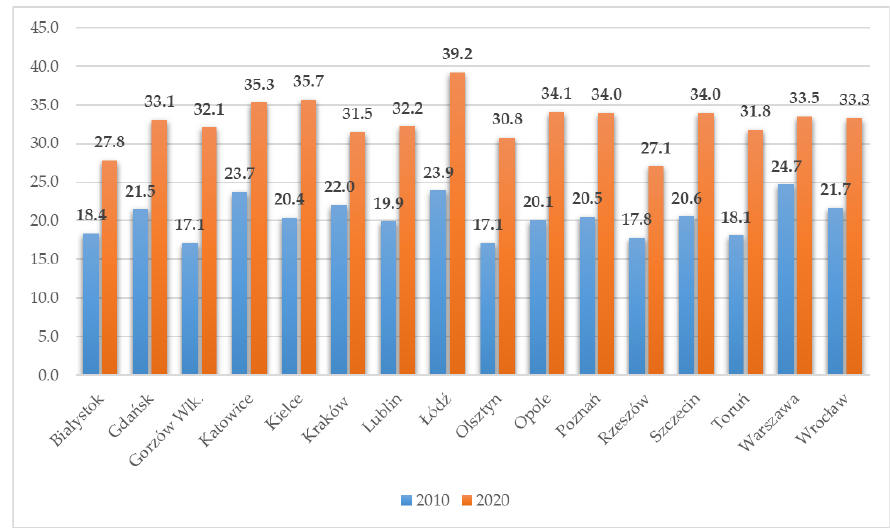
Figure 3. The elderly burden ratio in the surveyed Polish cities in 2010 and 2020.